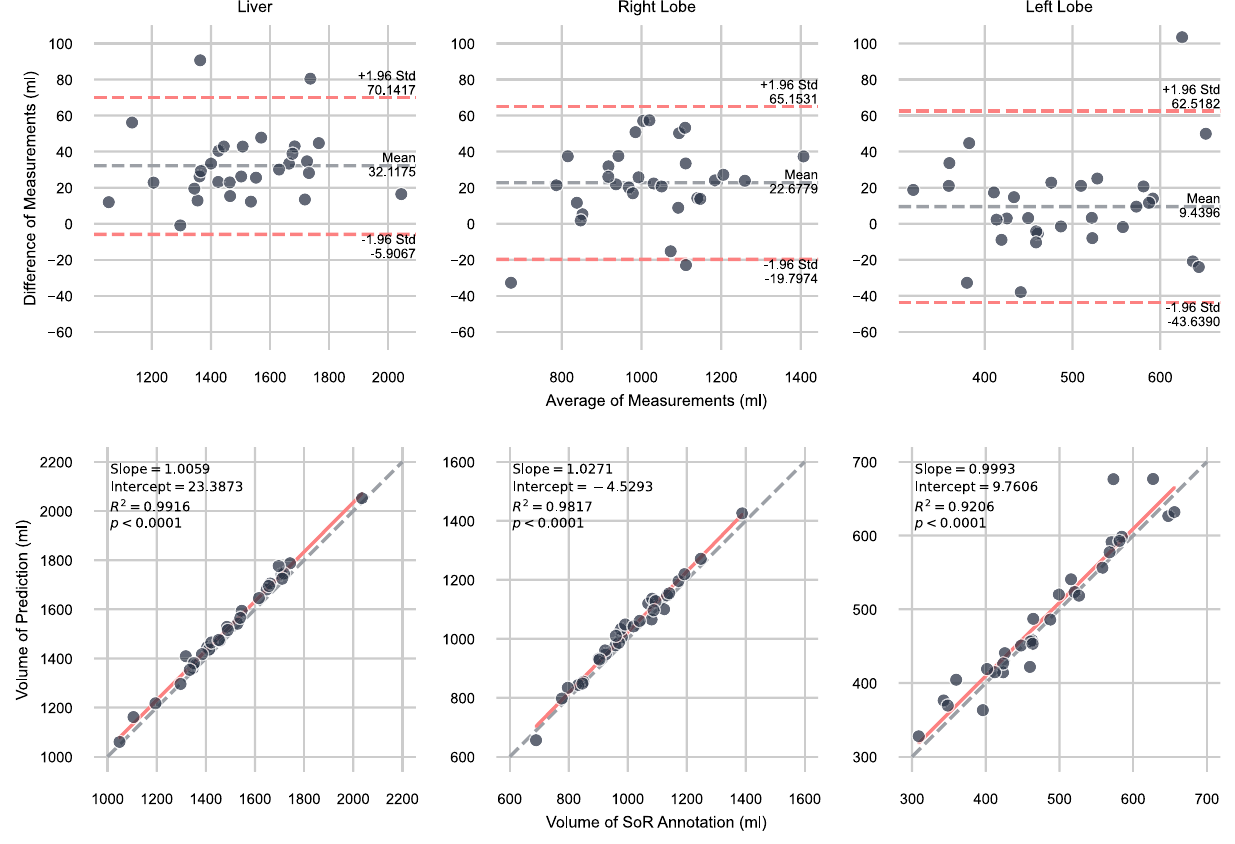
Figure 5. Analysis of the predicted volume versus the volume of the SoR groundtruth. (top) Bland–Altman diagrams (bottom) Scatter plots with OLS regression analysis.